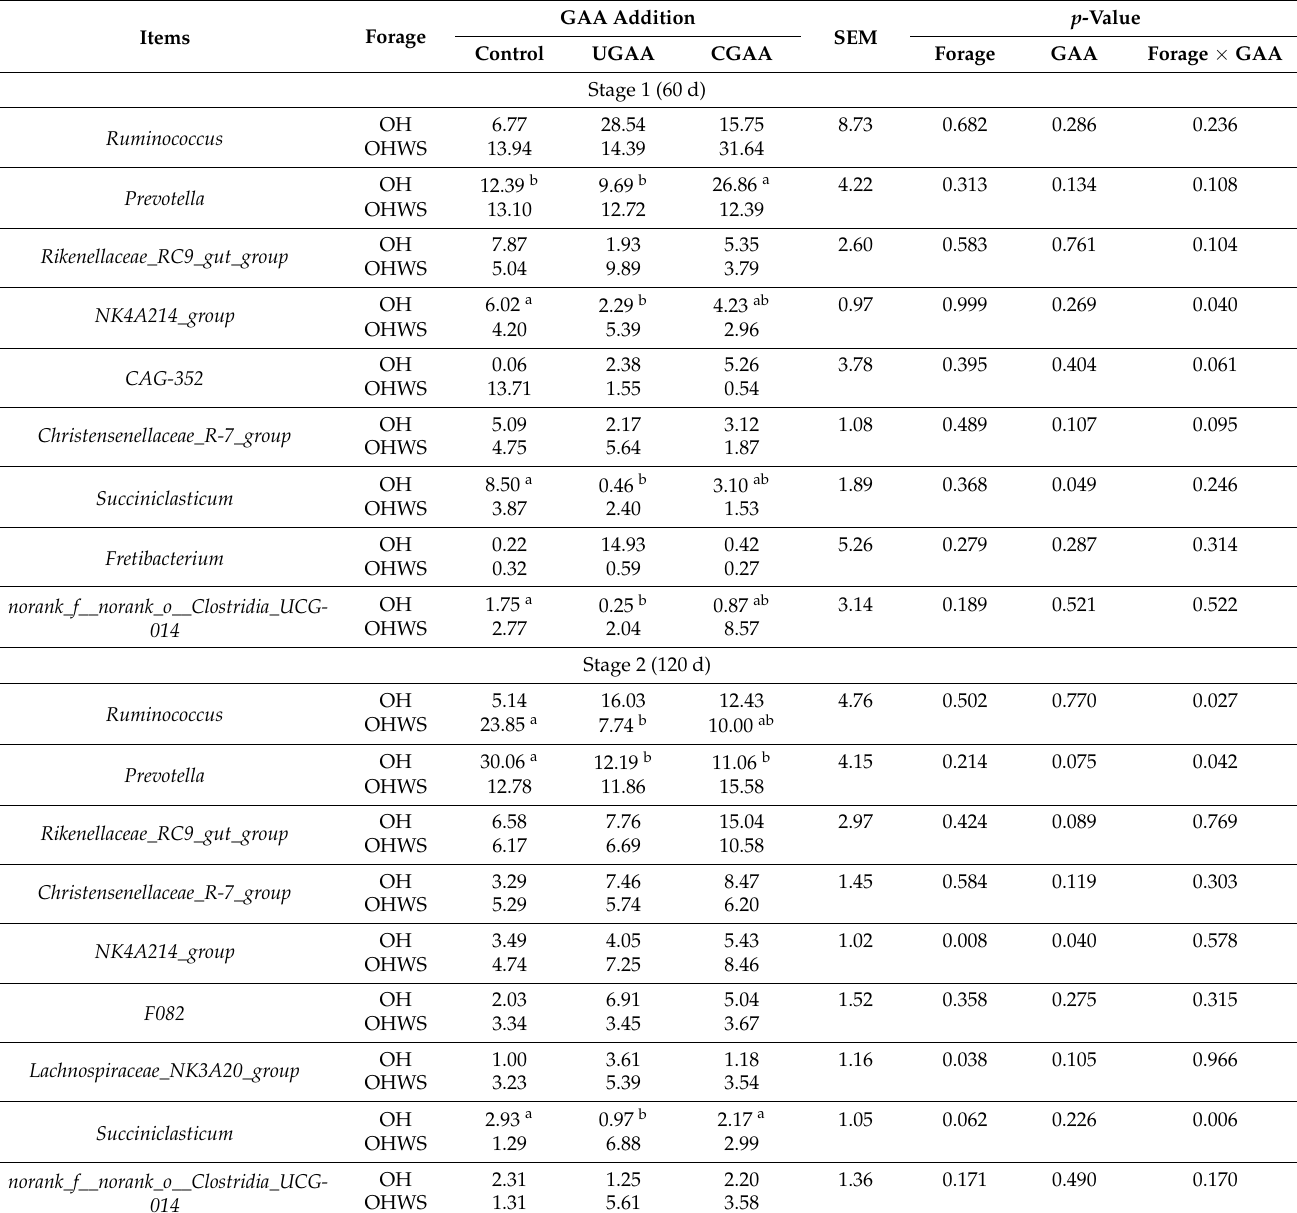
Table 4. Microbial community analysis at the genus level (relative abundance > 5%) of microbiomes obtained from rumen fluids of lambs at different feeding